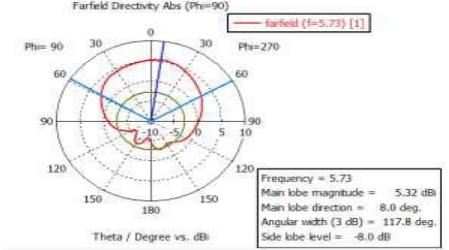
Figure 4.4: Farfield radiation pattern for 5.73GHz.